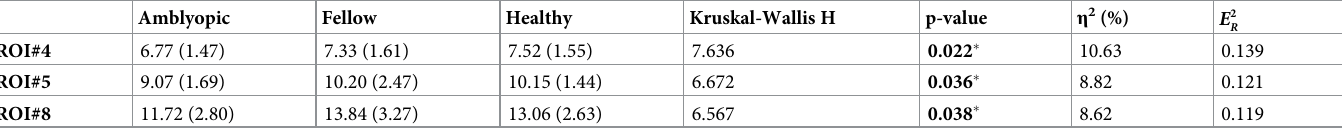
Values are median (IQR). IQR is the interquartile range � p-value < 0.05 is considered